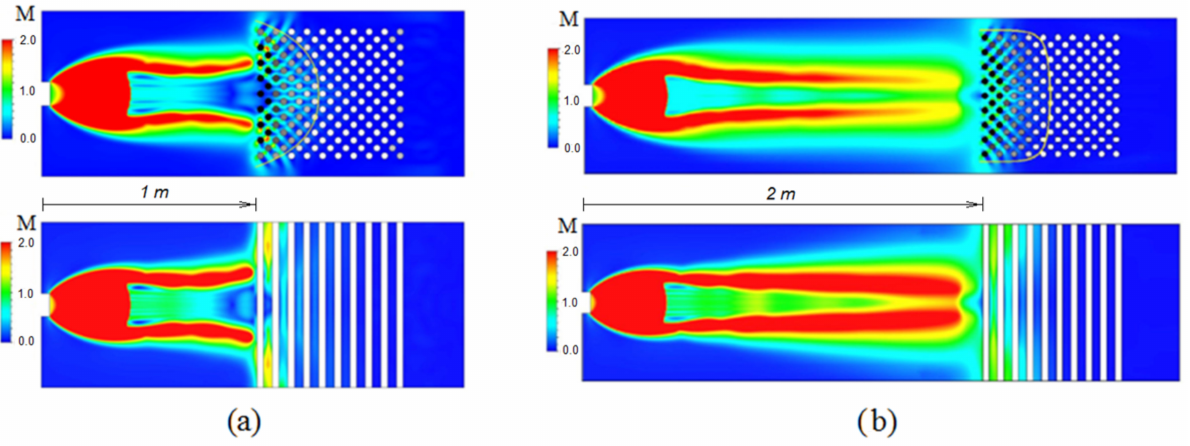
Figure 5. Blowing of the tube package with an air jet with a pressure of P 0 = 2.35 MPa. ( a ) Case 9; and ( b ) case 13. Upper—XOY plane, lower—XOZ